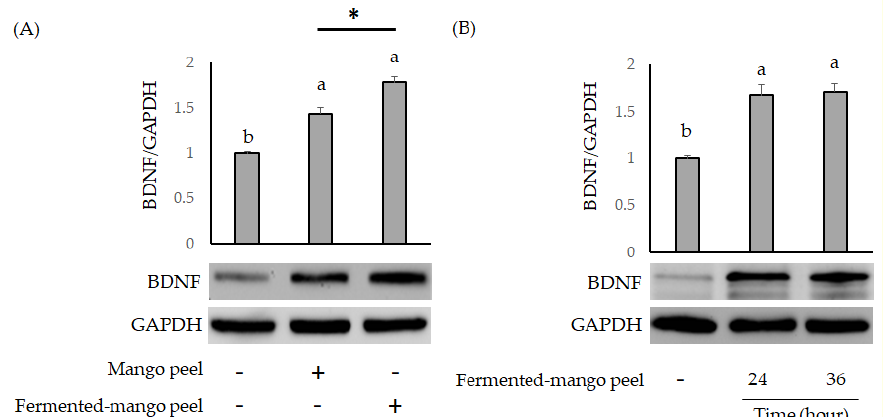
Figure 4. ( A ) The effects of mango peel and L. acidophilus (BCRC14079) fermented-mango peel extracts (100 µ g/mL) on upregulation of BDNF in Neuron-2A cells after 36 h treatment. ( B ) The promotion of BDNF expression in Neuron-2A cells treated with L. acidophilus (BCRC14079) fermented-mango peel for 24 h and 36 h. Data are shown as means ± SD ( n = 3). Significant differences are shown by various letters ( p < 0.05). p values were also determined by Student’s t -test (*, p < 0.05).